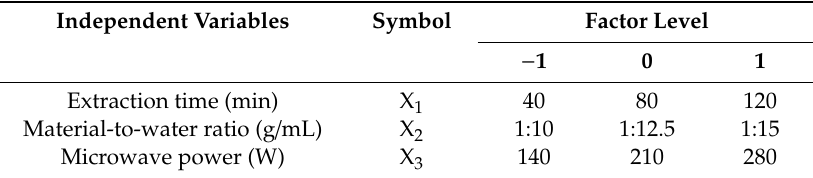
Table 1. Coding of independent variables and factor levels. Independent Variables Symbol Factor